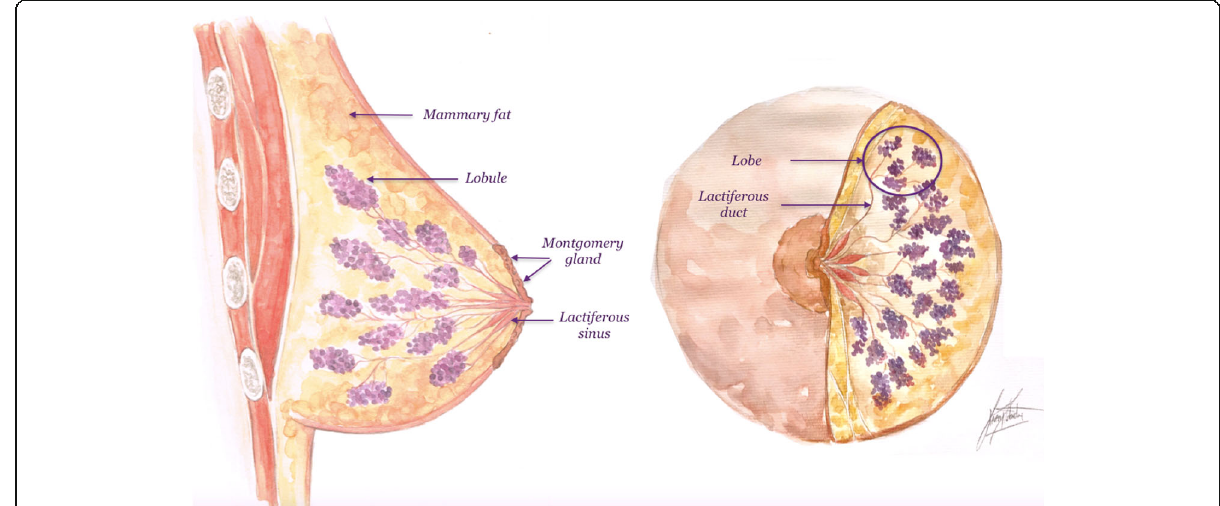
Fig. 1 Anatomy of the nipple-areolar complex